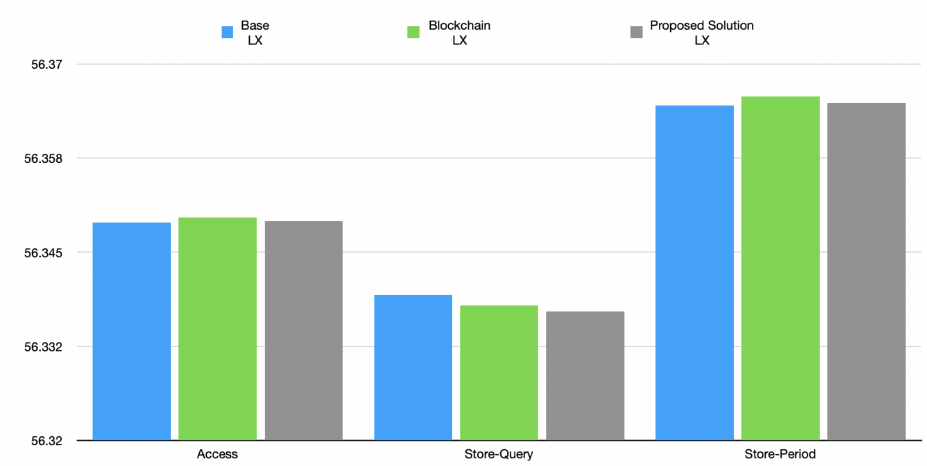
Figure 8. Energy consumption overhead (CPU and Tx).